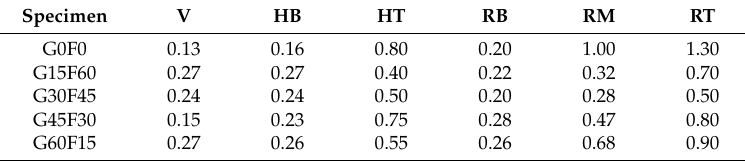
Table 11. Regression Parameter b .